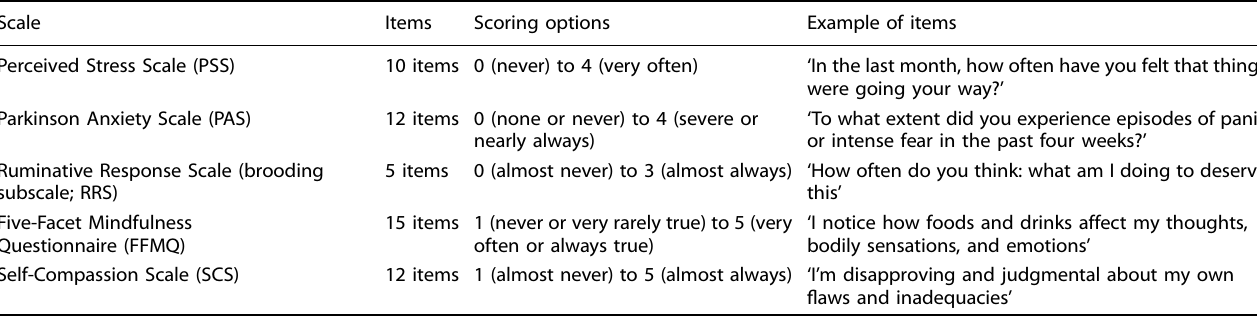
Table 1. Validated measures used in the one-time stress